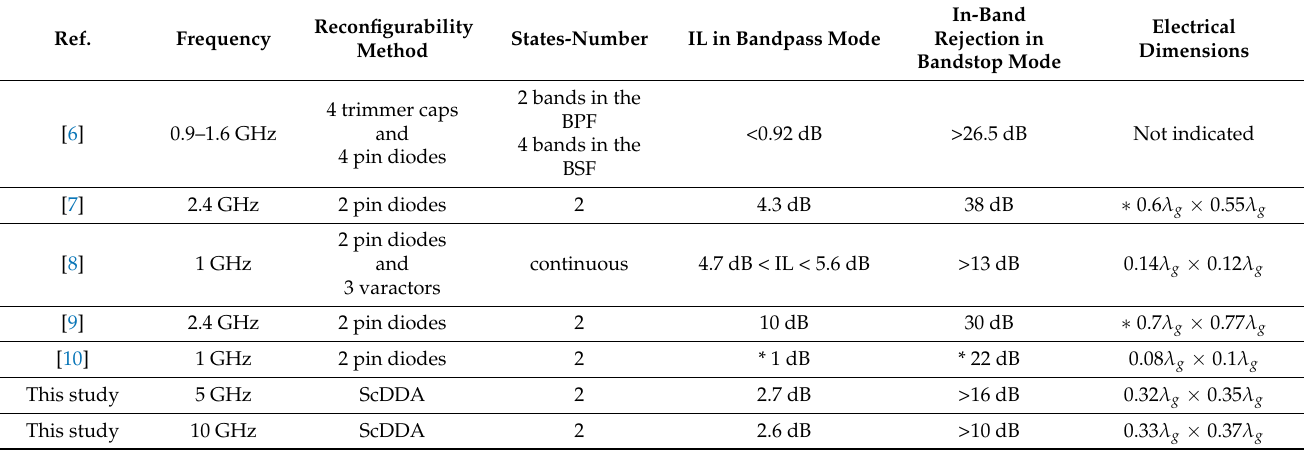
Table 8. Comparison with previous reconfigurable bandpass to bandstop filters and this work.